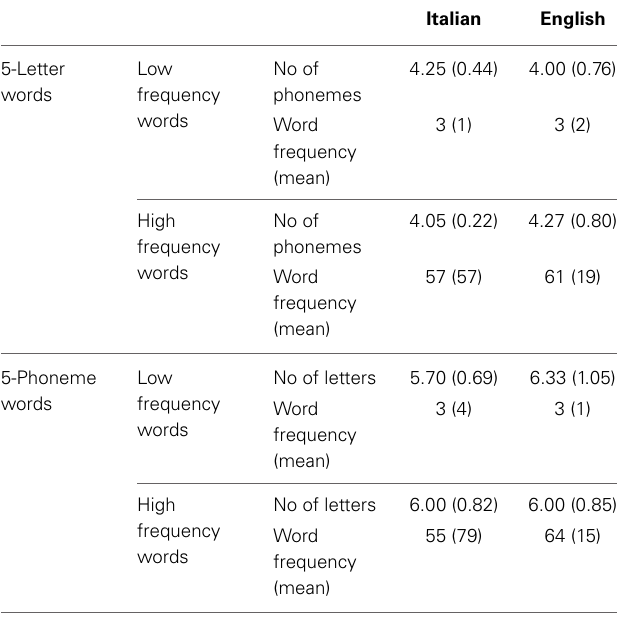
Table 3 | Characteristics of Italian and English 5-letter and 5-phoneme (high- and low-frequency) words in Experiment